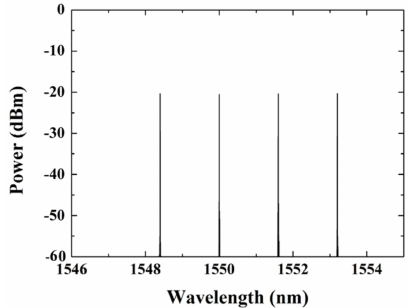
Figure 8. The spectrum of even signals at the output port 2 realizing OXC